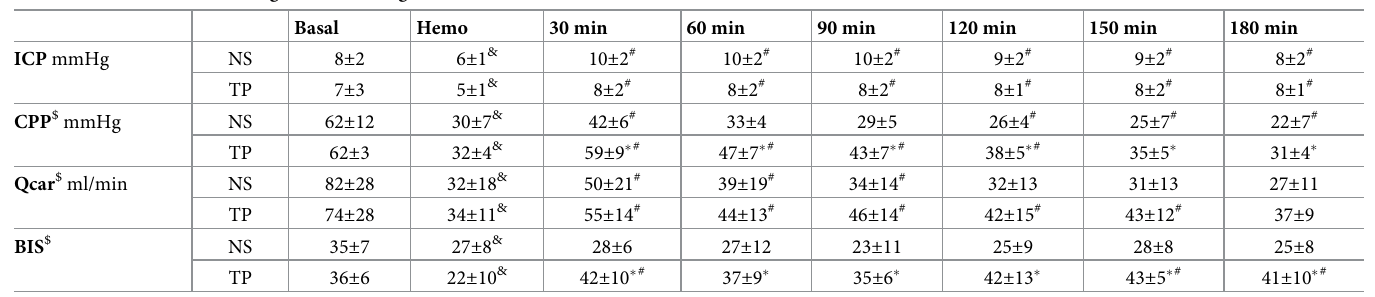
Table 3. Results of the neurological